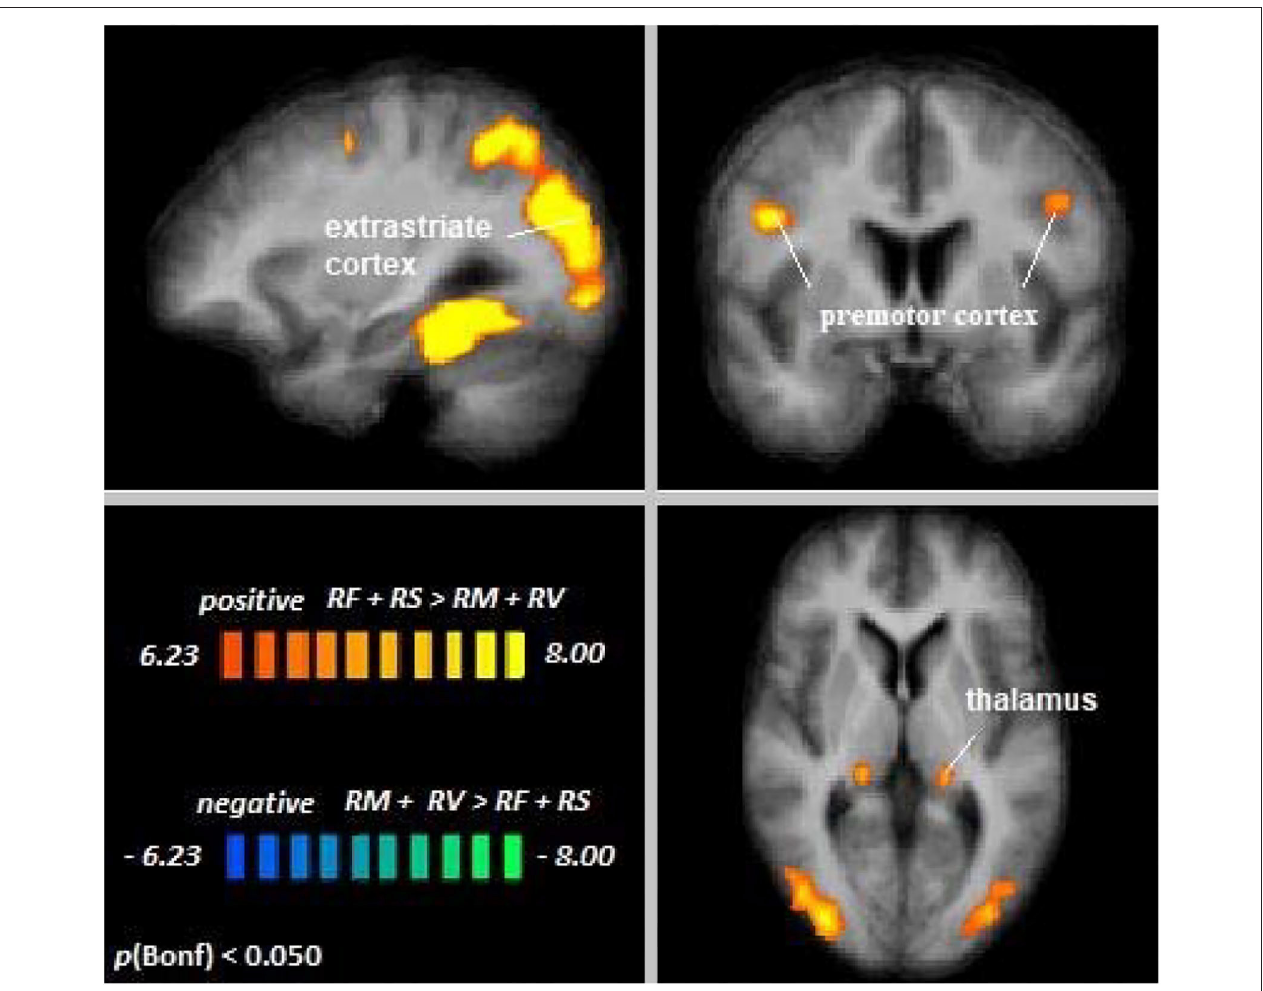
FIGURE 5 | Remember faces and remember scenes vs. remember music and remember voices. An overview of significant clusters for the contrast RF + RS > RM + RV. Sagittal, coronal, and axial planes are shown at x = 3, y = 6, z = 2. Active clusters show voxels with increased activation in visual relative to auditory selective attention